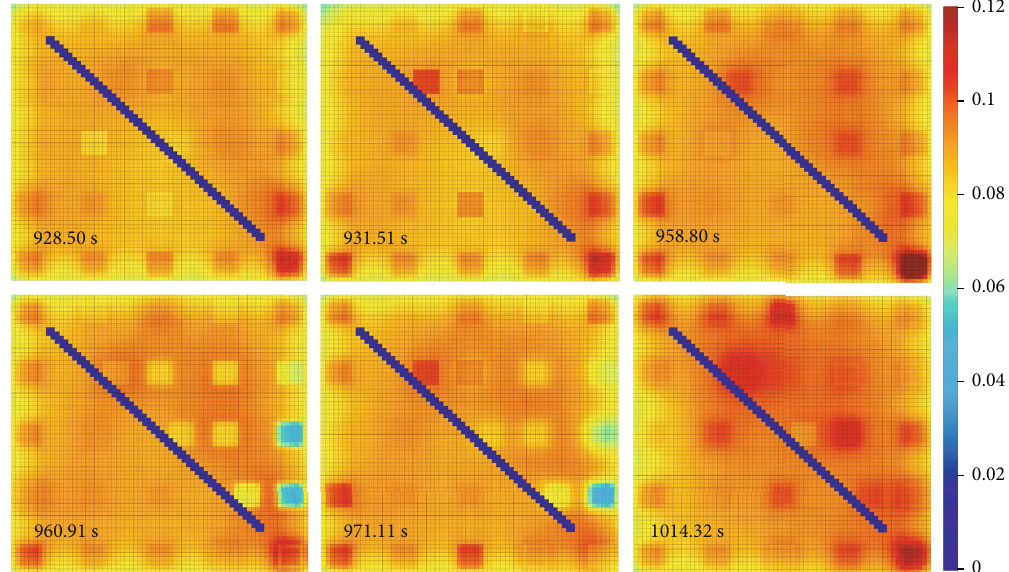
Figure 8: Di ff usion deduction model of AIRT increment under 14MPa before peak stress (black line indicates the prefabricated crack), reading from left to right and then up to the